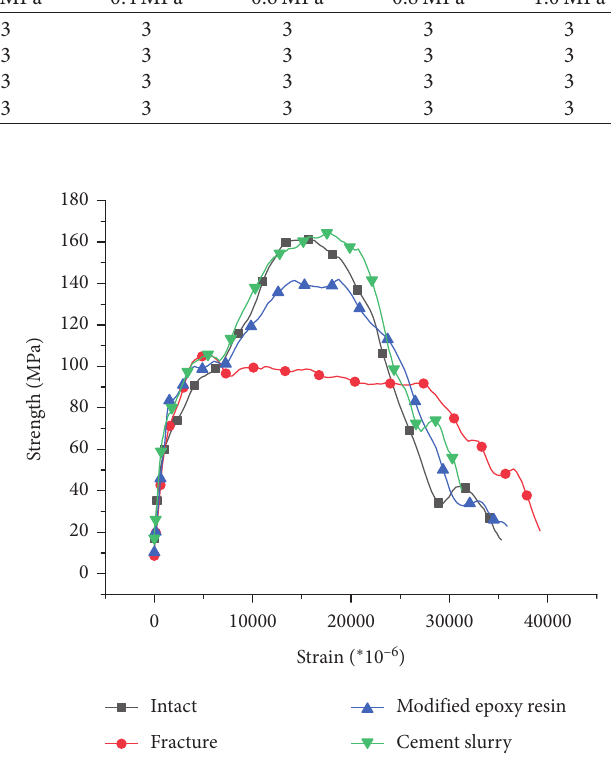
Figure 3: Typical dynamic stresses on both ends of specimen. Figure 4: Stress-strain curve of four types of specimens (0.6MPa).